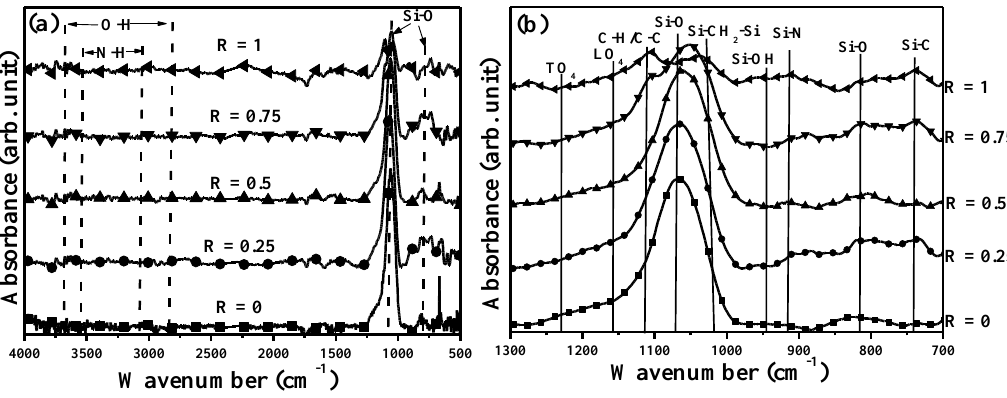
Figure 3. ( a ) Fourier transform infrared (FTIR) spectra of the films as a function of the ammonia gas flow ratio in the glow discharge and ( b ) a highlight of the spectra at wavenumbers ranging from 700 to 1300 cm -1 .